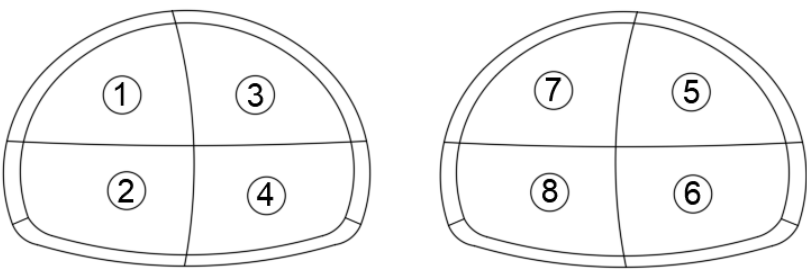
Figure 3. Separate tunnel excavation sequence diagram.